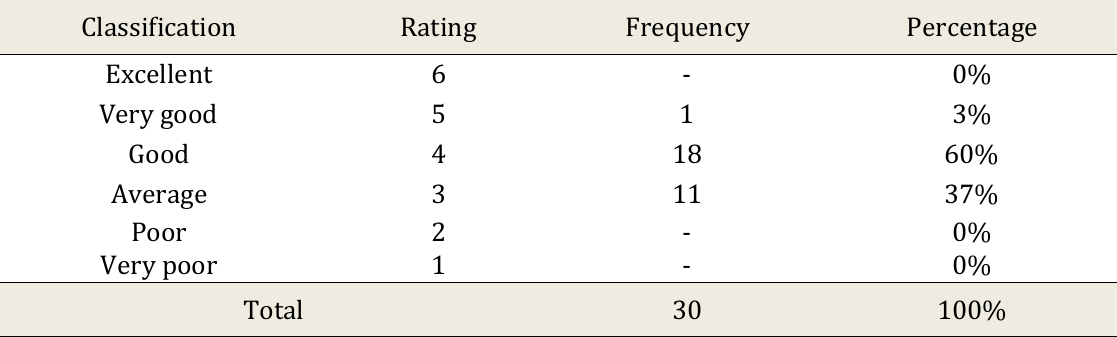
Table 4.12 The percentage Rate value of Students' smoothes in Posttest Result in Experimental